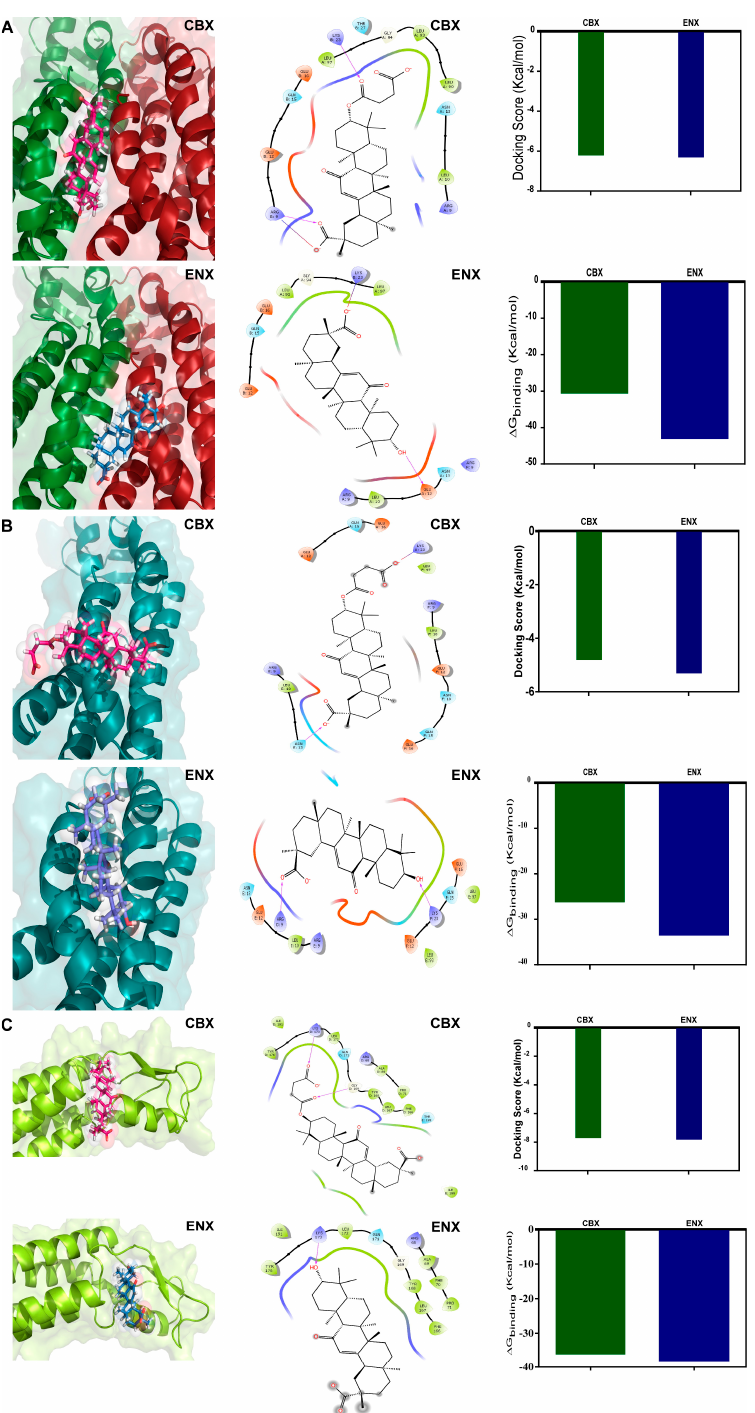
Figure 6. Molecular docking of CBX and ENX in the structure of HCs-Cx46. ( A – C ). Representative interaction between HCs-Cx46, CBX (magenta), and ENX (light blue) in the three cavity predicted previously. All the chains are identical, each monomer is represented with a different color to facilitate the identification of the regions between subunits. Comparison of CBX/ENX docking in the NT domains of HCs-Cx46. 2D diagram of the interactions identified for HCs-Cx46. The CBX and ENX binding site residues that interact with the NT of HC-Cx46 are shown schematically and colored according to their physicochemical properties. The arrows indicate the directionality of the hydrogen bond and the degraded line represent a salt bridge. Plots of docking scores and theoretical binding Δ G between CBX/ENX interactions with HCs-Cx46.